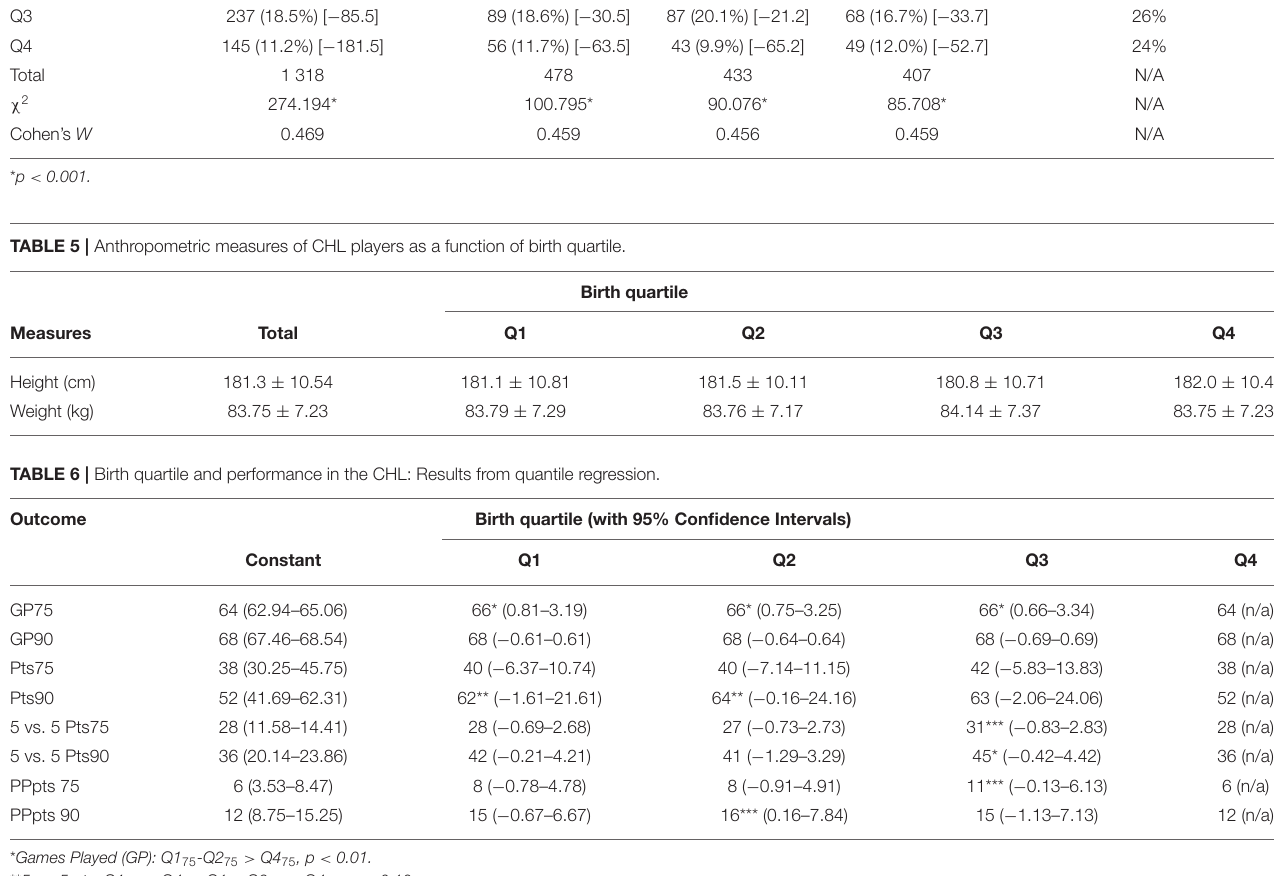
TABLE 4 | Distribution of births in each quartile in the Canadian hockey league (CHL). Birth quartile